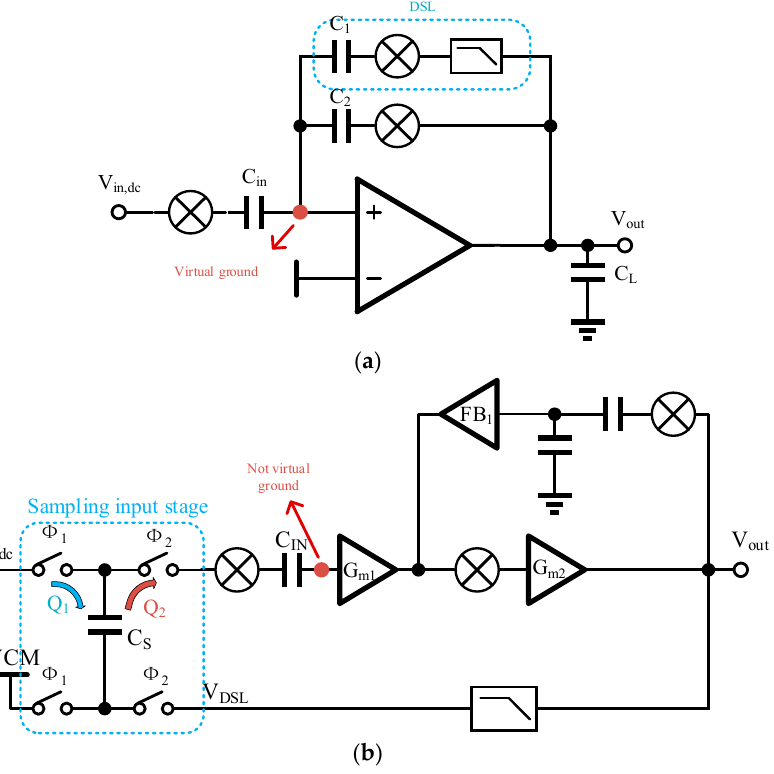
Figure 4. DC input impedance analysis: ( a ) traditional ( b ) proposed.